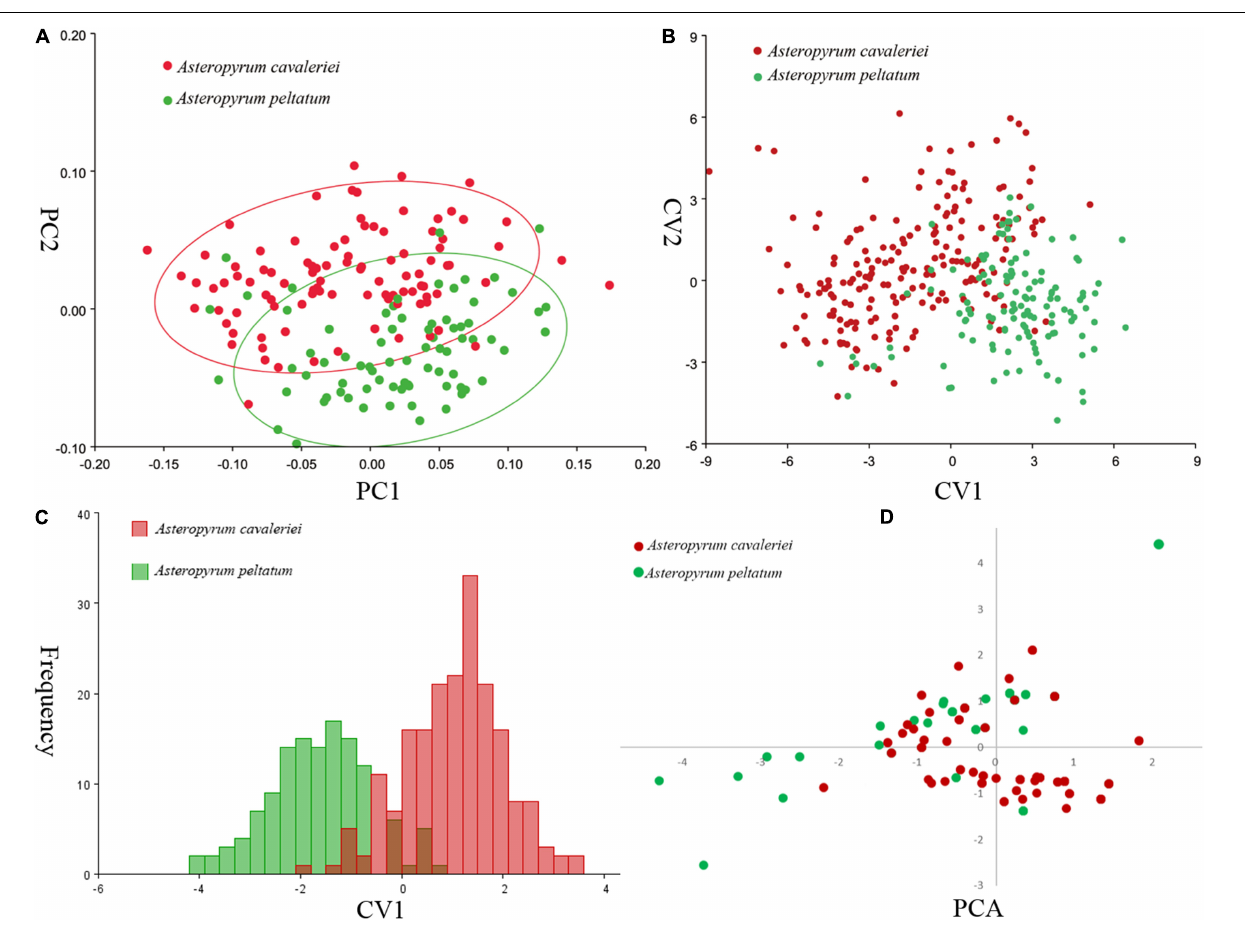
morphospecies were not reciprocally monophyletic, albeit most clades did not receive strong bootstrap support ( Figure 1D